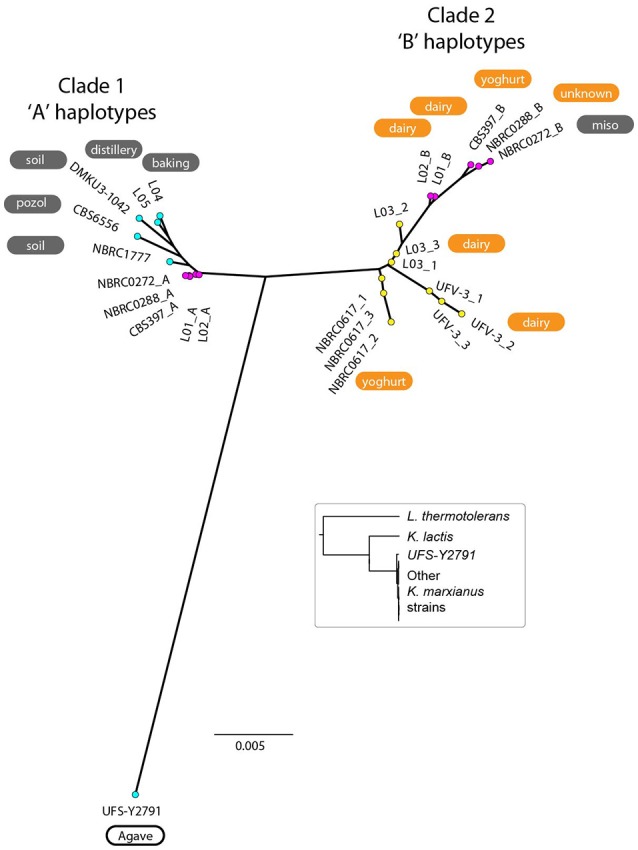
Phylogenetic tree of K. marxianus haplotypes. Coloured dots indicate the ploidy of strains as haploid (cyan; 1 haplotype per strain), diploid (magenta; 2 haplotypes per strain), or triploid (yellow; 3 haplotypes per strain). The environmental source of each strain is shown (for diploid strains, the source is only labeled on the “B” haplotype). Orange backgrounds indicate Lac+ strains, grey backgrounds indicate Lac− strains, and white backgrounds indicate Lac phenotypes not tested. The tree was constructed from SNP data from regions that are heterozygous in diploids, totalling 18% of the genome. Inset, phylogenetic tree constructed from DNA sequences of GCN1 (an arbitrarily chosen large gene), confirming that UFS-Y2791 is a strain of K. marxianus.